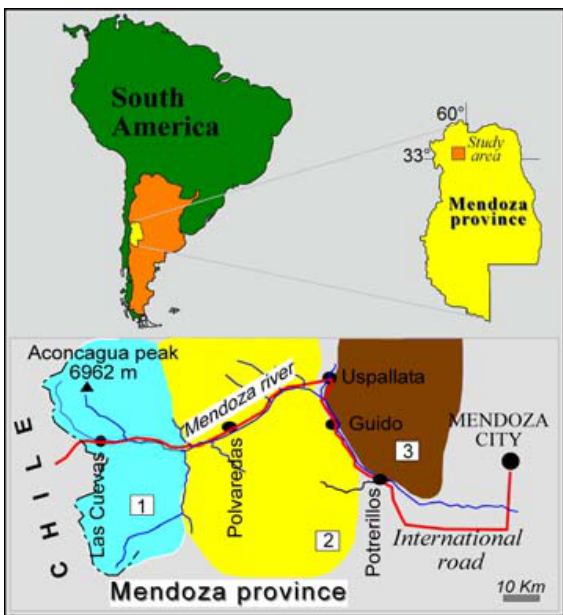
Fig. 1. Mendoza Province 1(CP) 2(CF) 3(P).